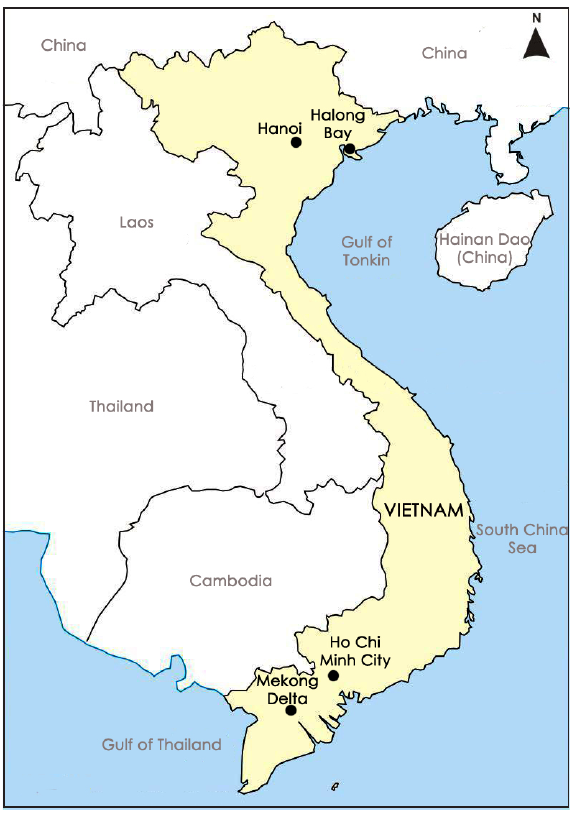
Figure 1. Map of Vietnam showing the four areas where the surveys were